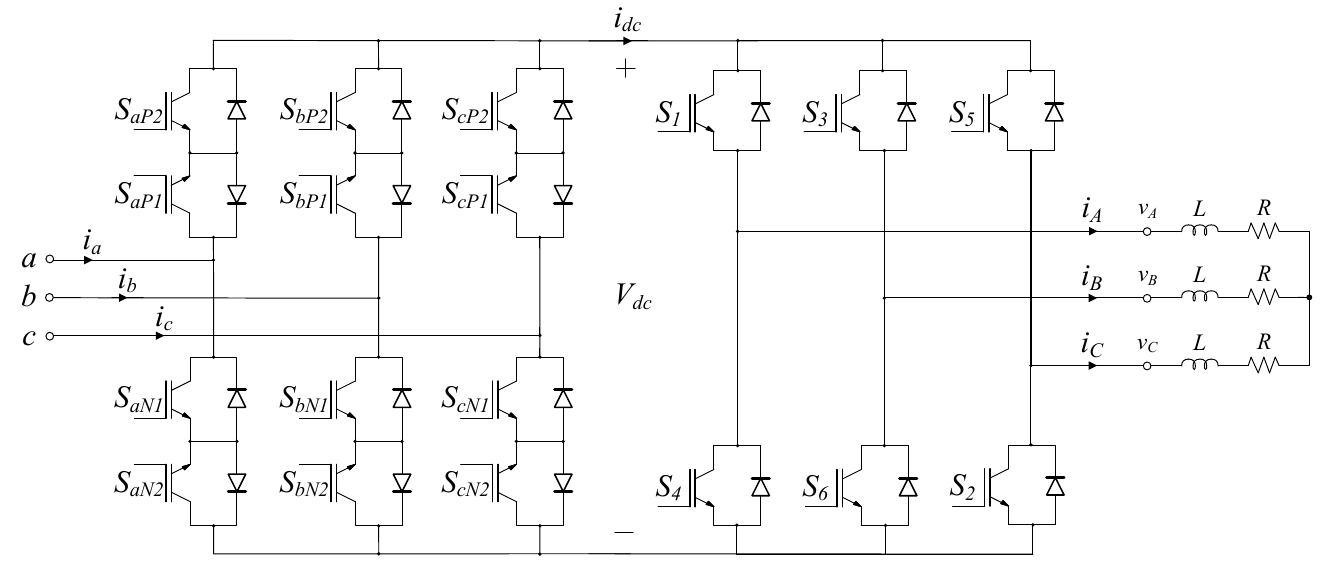
Figure 19. Power circuit of the IMC modeled for simulation.